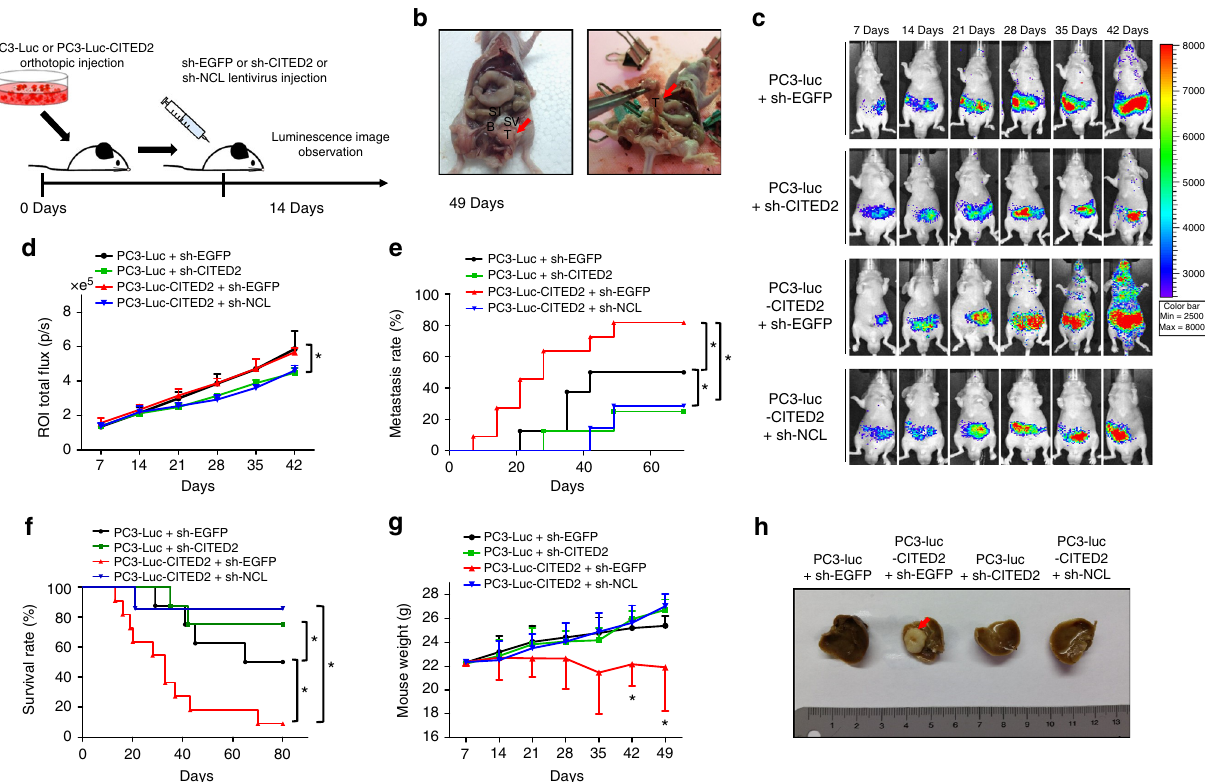
Fig. 6 CITED2 promotes prostate cancer metastasis NCL-dependently in mice. a Schematic diagram of in vivo prostate metastasis model. b Representative photographs of prostate tumors 10 weeks after cell implantation. The luciferase-expressing PC3 cells (0.5 × 10 6 ) were suspended in 20 μ L of sterile PBS and injected into the prostates of Balb/cSlc-nu/nu mice. c Bioluminescent images of primary tumors and metastases were monitored using Xenogen IVIS ® Lumina 100. Color scale bars represent tumor intensity from purple (low) to red (high). d Growth curves of primary tumors were plotted based on bioluminescence intensities. Data are presented as the mean + SD, and * P < 0.05 between two groups by Mann – Whitney statistical analysis. Mouse numbers are 8 in the sh-EGFP group, 8 in the sh-CITED2 group, 11 in the CITED2 + sh-EGFP, and 7 in the CITED2 + sh-NCL group. e Metastasis rate was retrieved according to the Kaplan – Meier method and * P < 0.05 between two groups. Metastasis de fi ned as ROI fl ux value was larger than 1.0 × e 5 . f Kaplan – Meier overall survival rate analyses were followed up until 80 days after xenograft and * P < 0.05 between two groups. g Tumor-bearing mice were weighed in the indicated times. Data are presented as the mean + SD, and * P < 0.05 between two groups by Mann – Whitney statistical analysis. h Representative photographs of livers with metastatic carcinoma nodules (indicated by